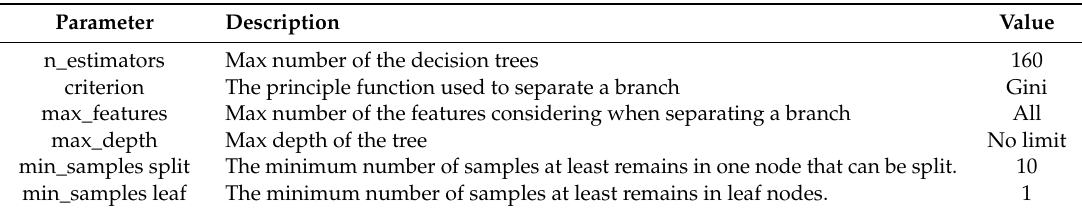
Table 4. The parameters used in the random forest algorithm.